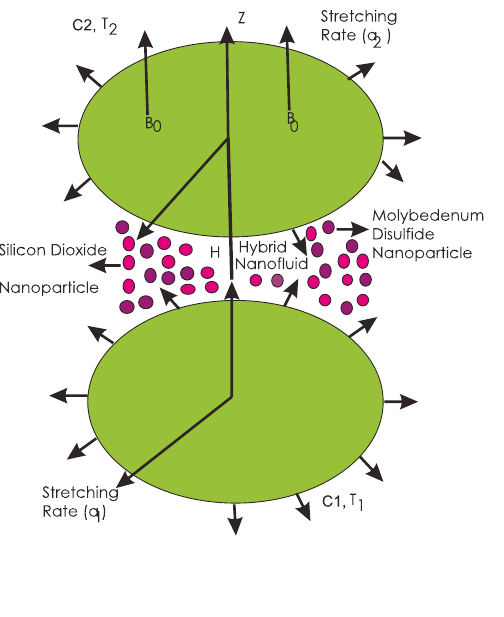
Figure 1. Geometry of the